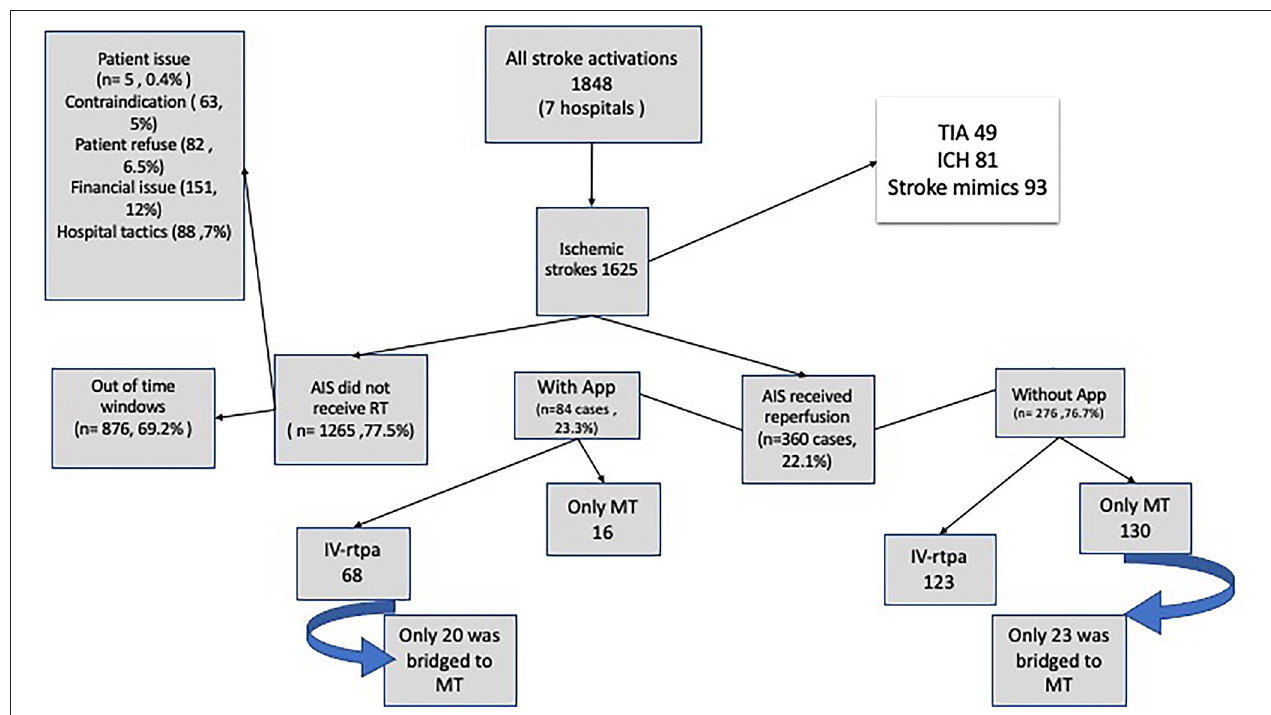
FIGURE 2 | Flowchart of the patients included in the study. ICH indicates intracranial hemorrhage; TIA, transient ischemic attack; and tPA, tissue-type plasminogen activator; MT, Mechanical thrombectomy; IA, Intraarterial; AIS, acute ischemic stroke.